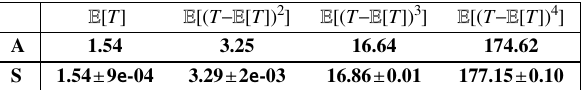
Table 1: Class 1 response time moments from TCP dataset 1.